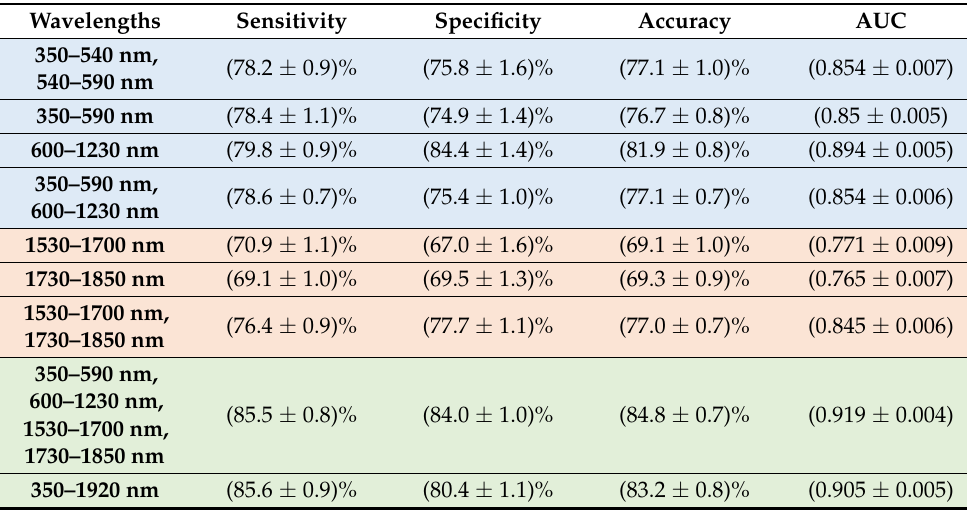
* Results corresponding to 2-fold cross-validation from 20 iterations of random sampling of training and test sets. Our validation provides a sufficiently robust estimation of classification performance metrics since